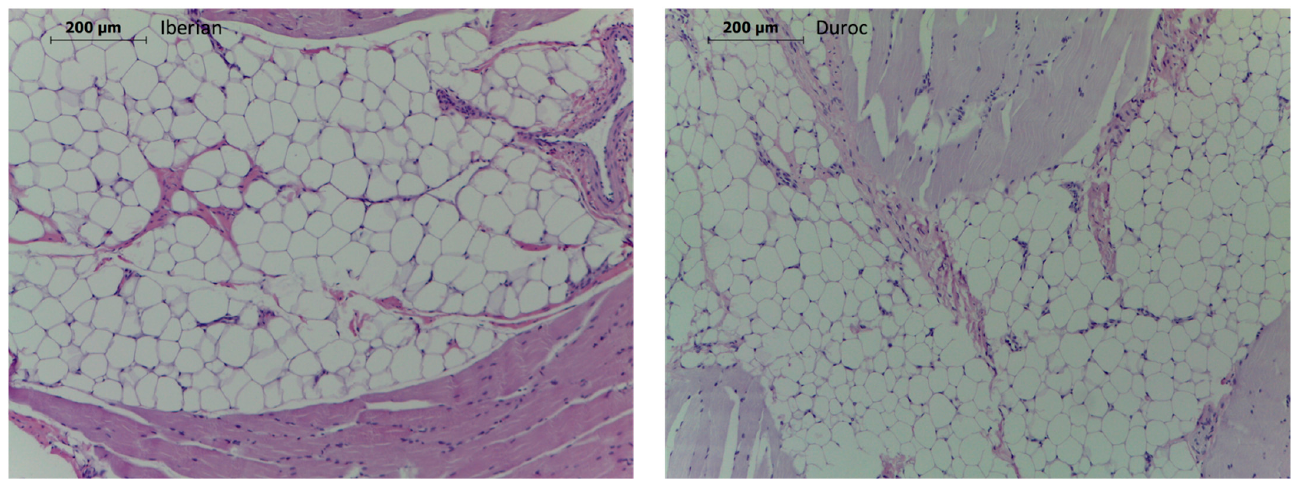
Figure 1. IMF adipocytes of BF muscle of Iberian and Duroc pigs, 91.1 versus 78.5 microns, respectively, for these particular samples (photomicrographs taken with a Leica ICC50W ™ camera coupled to a Leica DM1000 ™ microscope).